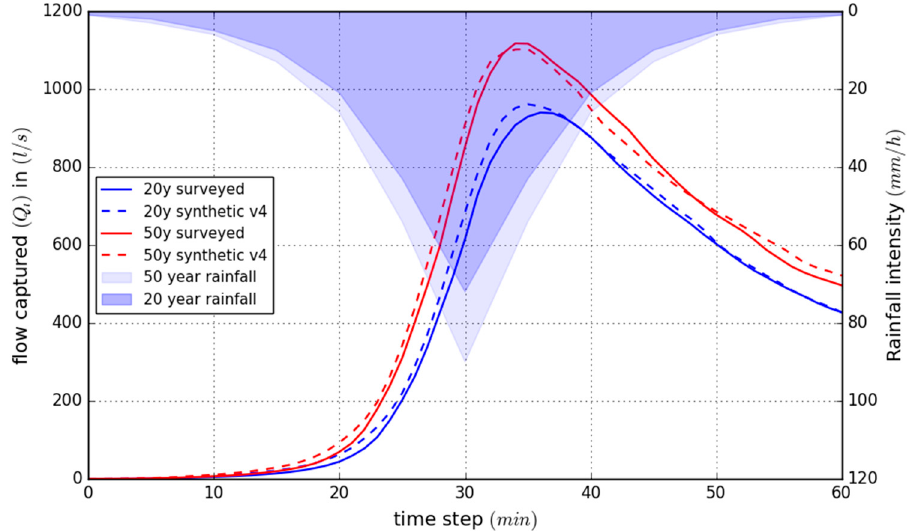
Figure 9. Comparison of flow captured (Qi) for surveyed and synthetic storm drain inlet network version 4 for a 20 and 50 year storm event.